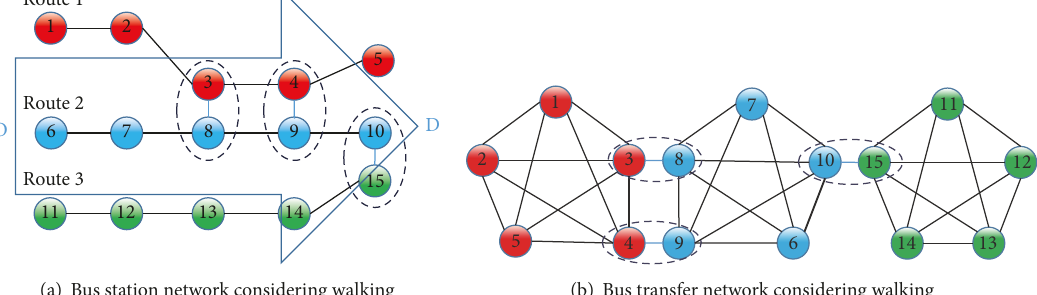
Figure 2: Sketch of bus networks considering